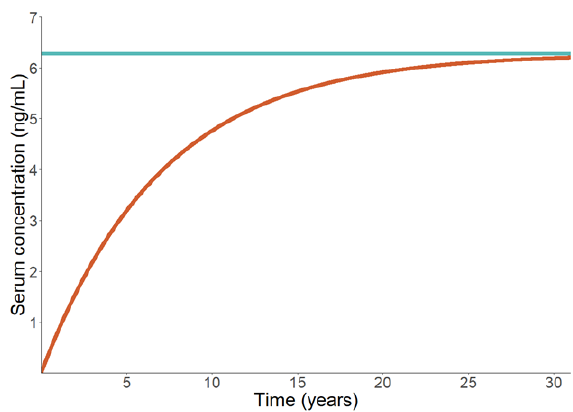
Figure 8. Dynamic (red line) versus steady state (green line) OCH model for PFOS.